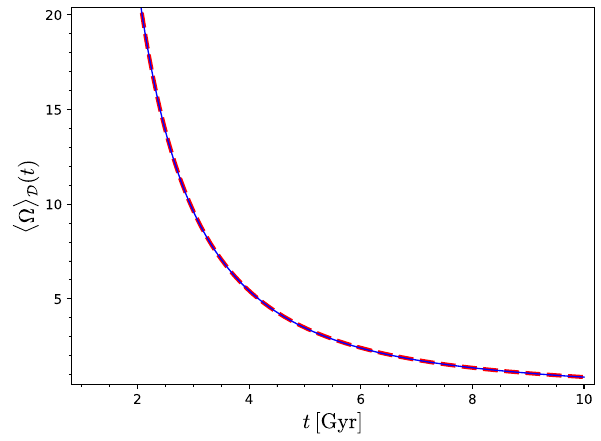
Fig. 3 Blue – the model average density expressed in the critical den- sity units as a function of time. Red dashed curve corresponds to the